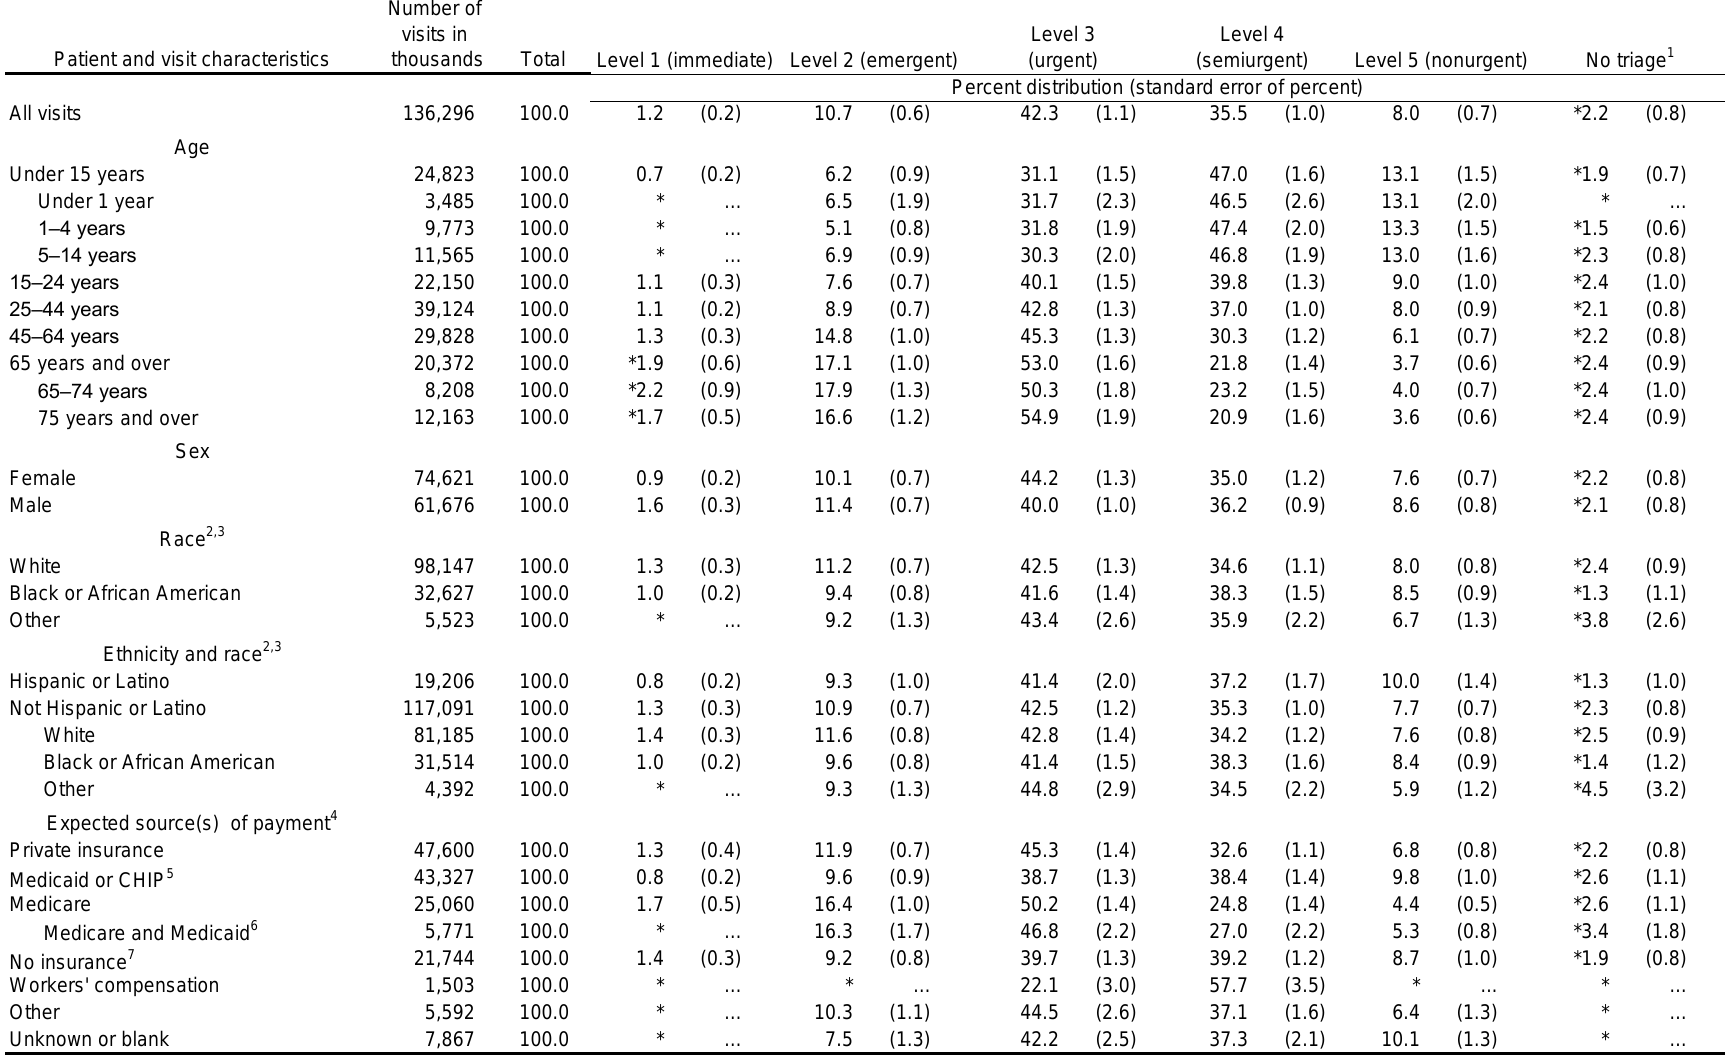
Table 7. Triage status of emergency department visits, by selected patient characteristics: United States,